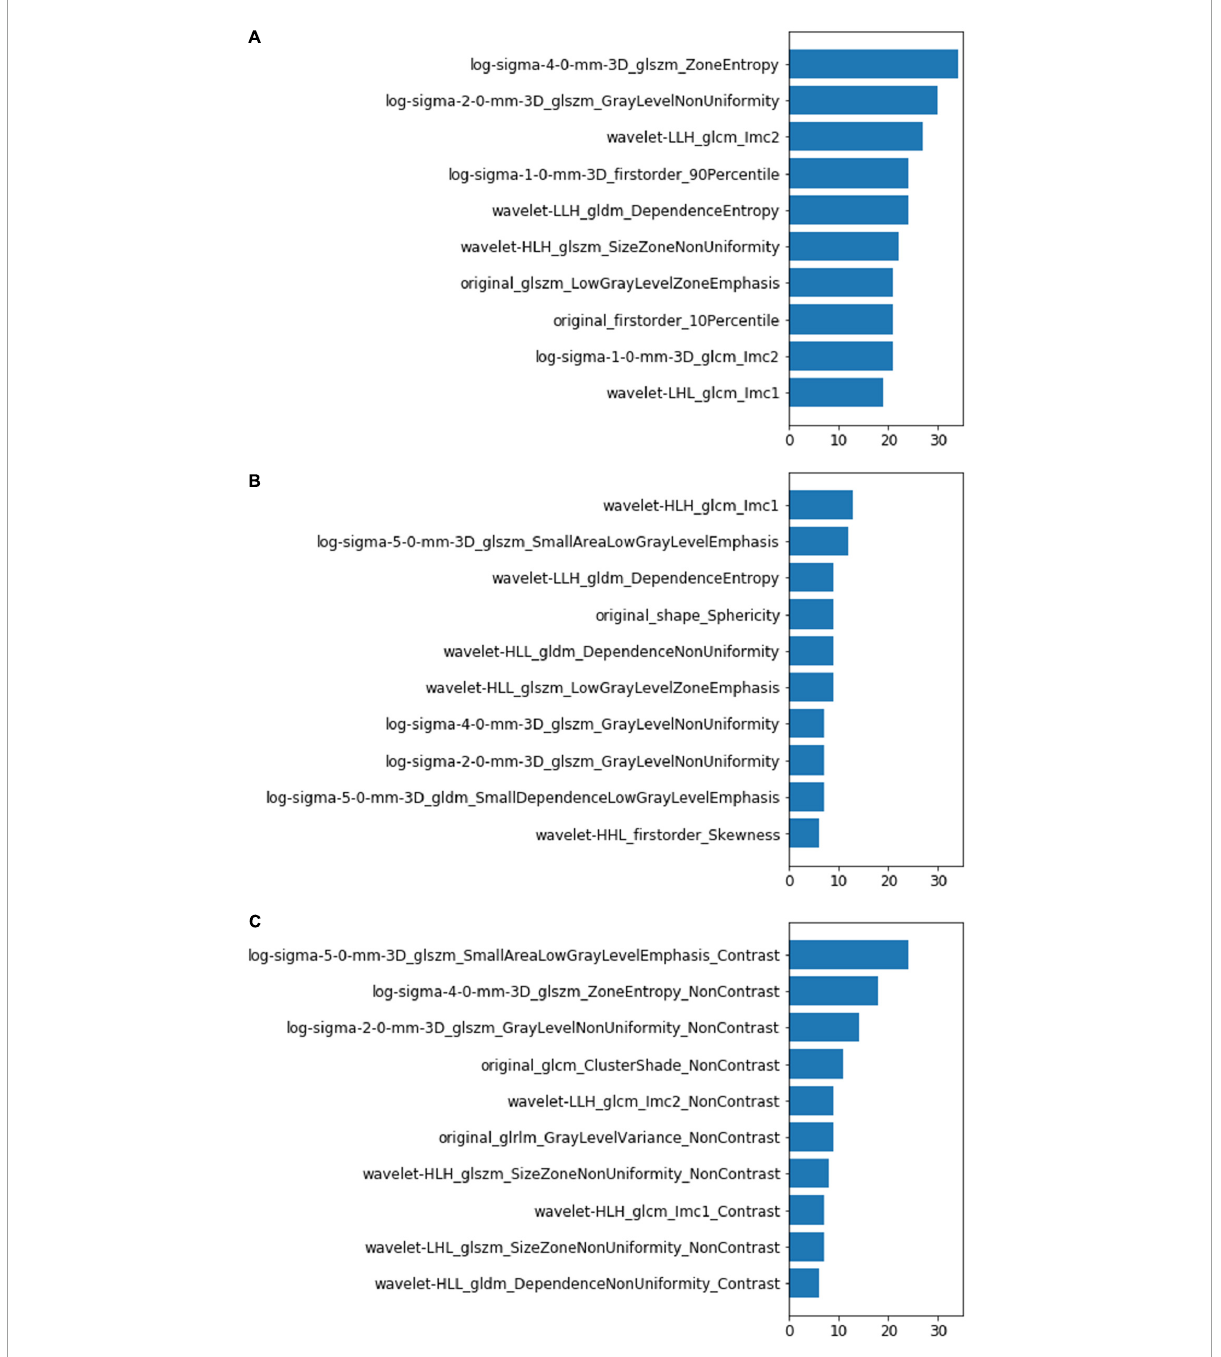
FIGURE4 Top 10 most-used features of the NCCT model (A) , CECT model (B) , and combined model (C) . The left vertical coordinates indicate the radiomic features; the horizontal coordinates indicate the number of times the features were used in the models.